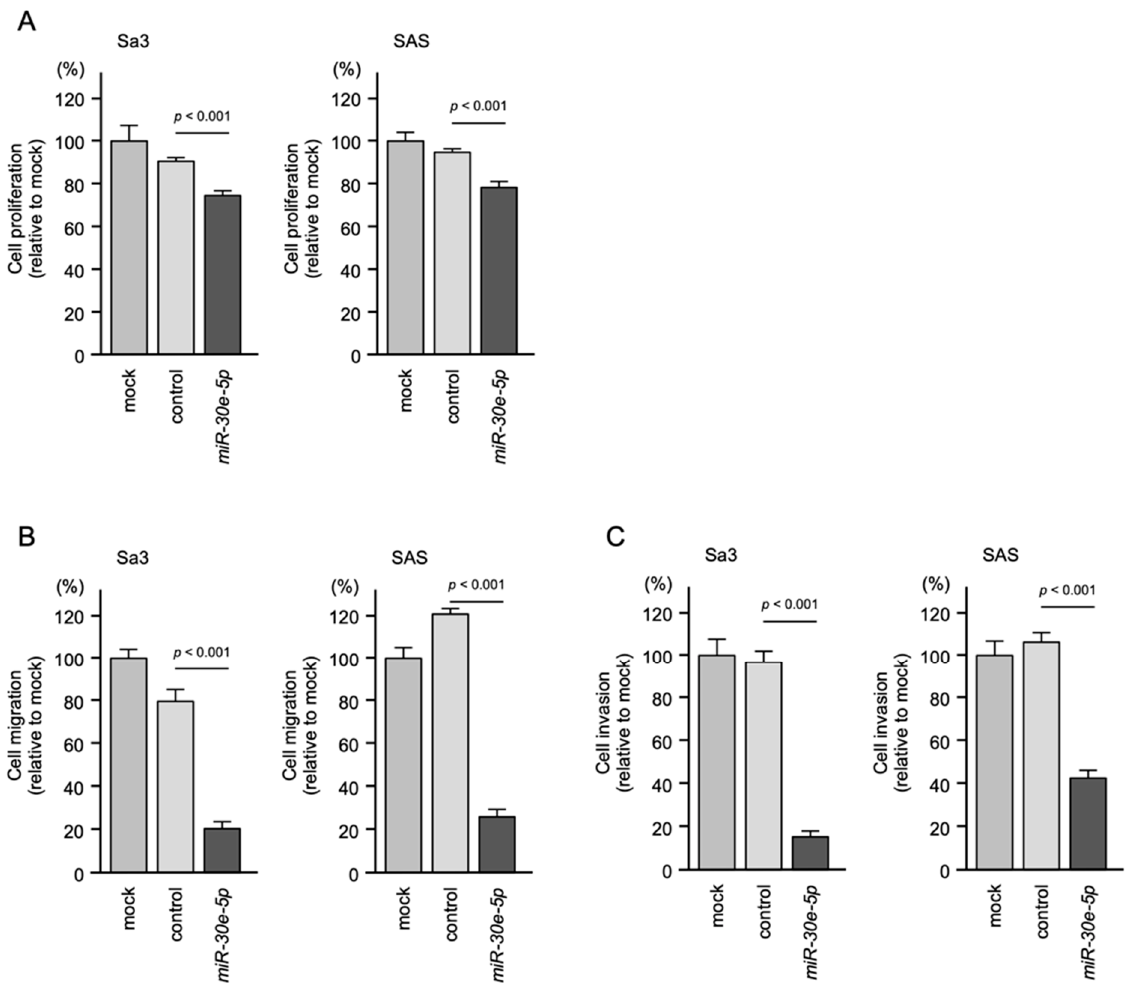
Figure 4. Functional assays of miR-30e-5p in HNSCC cell lines (Sa3 and SAS) . ( A ) Cell proliferation was assessed using XTT assays 72 h after miRNA transfection. ( B ) Cell migration was assessed using a membrane culture system 48 h after seeding miRNA-transfected cells into the chambers. ( C ) Cell invasion was determined using Matrigel invasion assays 48 h after seeding miRNA-transfected cells into the chambers.